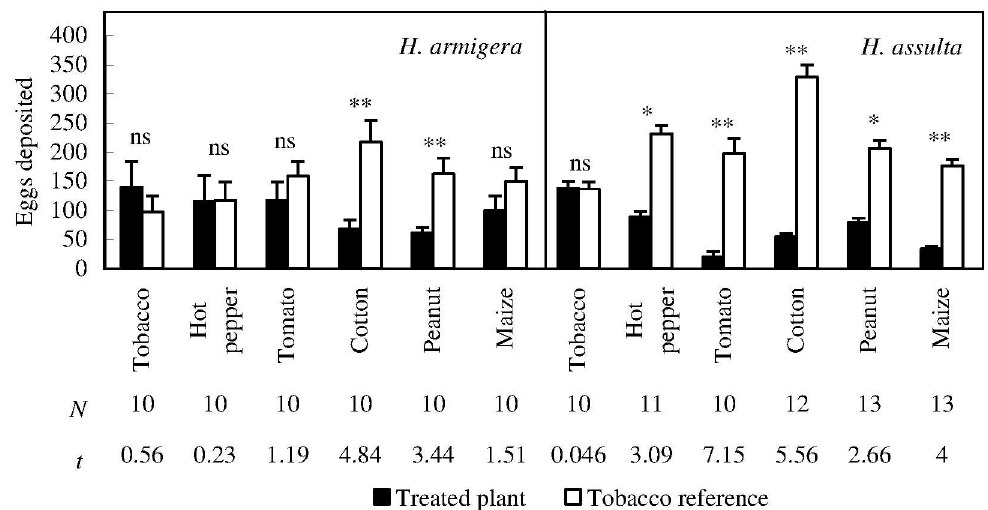
Fig 3. Ovipositional choice responses of H . armigera and H . assulta mated females under the conditions of each plant species paired with tobacco plant. “ * ” and “ ** ” at the upper panel of the figure indicatesignificant difference within group at P = 0.05 and P = 0.01 levels, respectively,and “ns” indicatesno significantdifference within group, tested by paired t test. The values of “ N ” and “ t ” beneathrespective bars indicate replications and statistical t values,